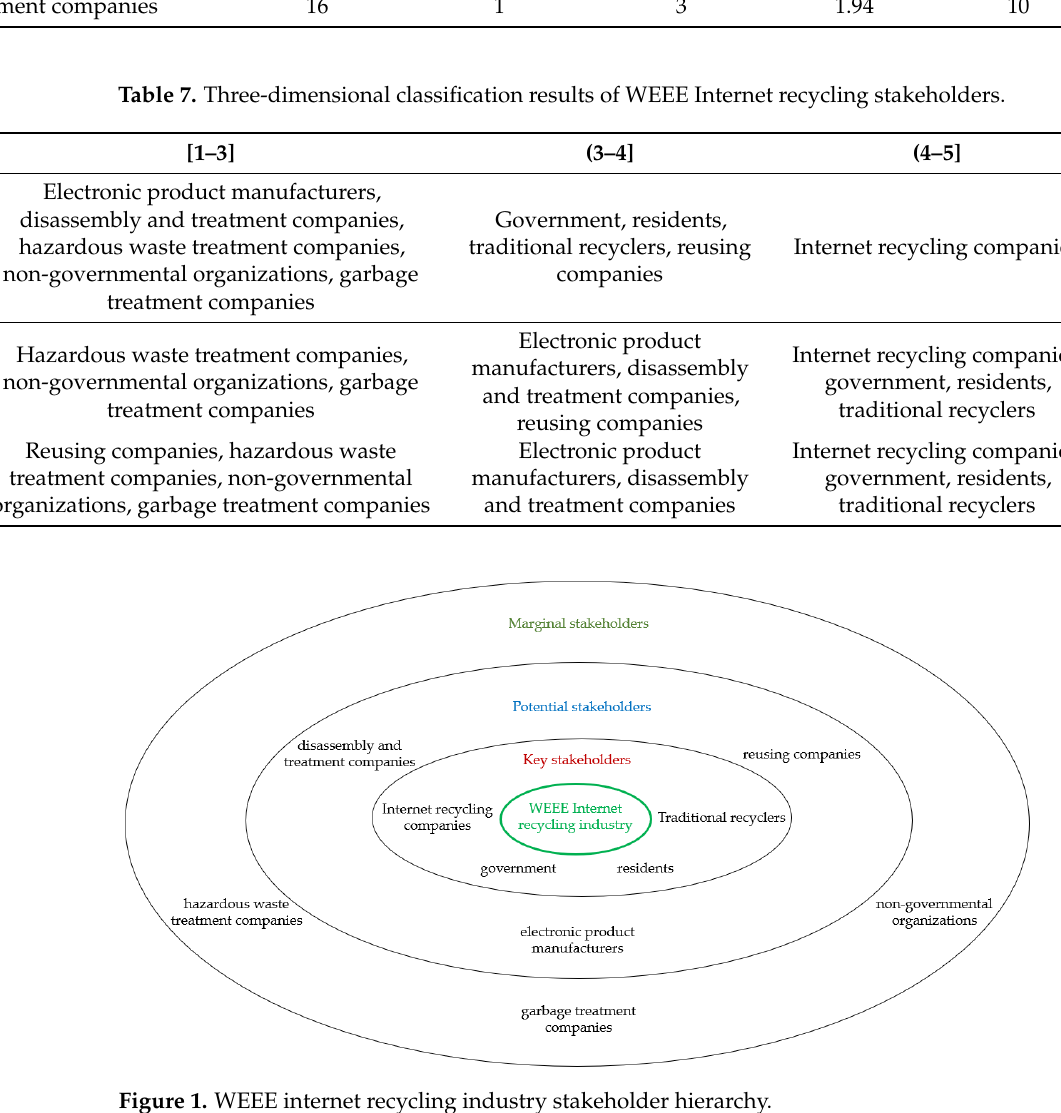
Figure 1. WEEE internet recycling industry stakeholder hierarchy.